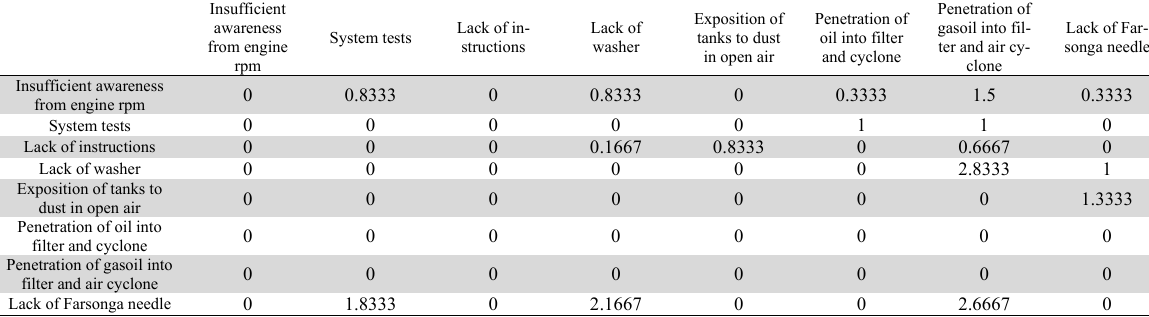
Matrix of direct relation